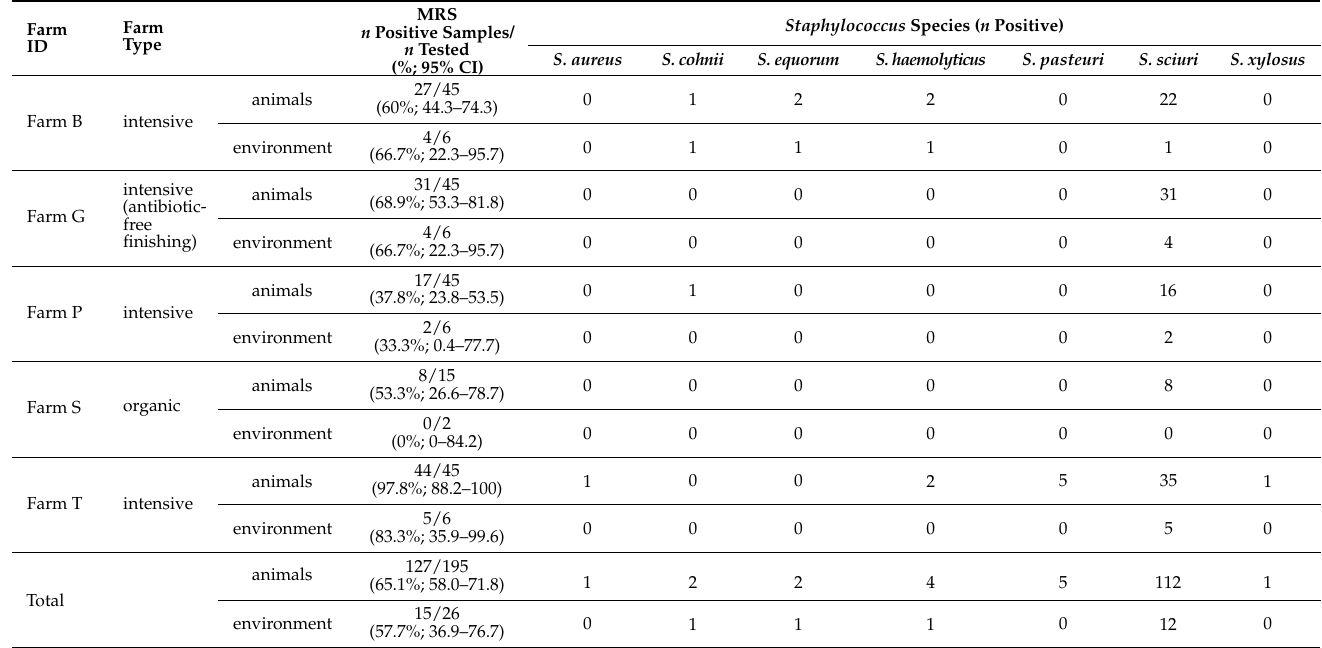
Table 1. Methicillin-resistant staphylococci (MRS) isolated from swine nasal swabs and the environment in five swine farms in northern Italy, 2019–2020.